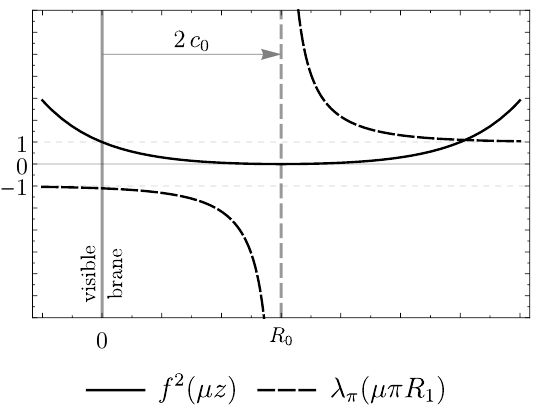
Figure 2. The metric warping (3.35) of the Nihei-Kaloper-Kim-Kim special case (solid) normalized such that f (0) = 1. The dashed line shows the normalized brane tension (cid:21) (cid:25) ( R 1 ) which the hidden brane must carry if it would be located at a distance R 1 away from the visible brane. There is a special radius z = (cid:25)R 0 for which the metric is zero and f 0 =f does not exist. If a brane is placed at this special radius it decouples and can have any brane